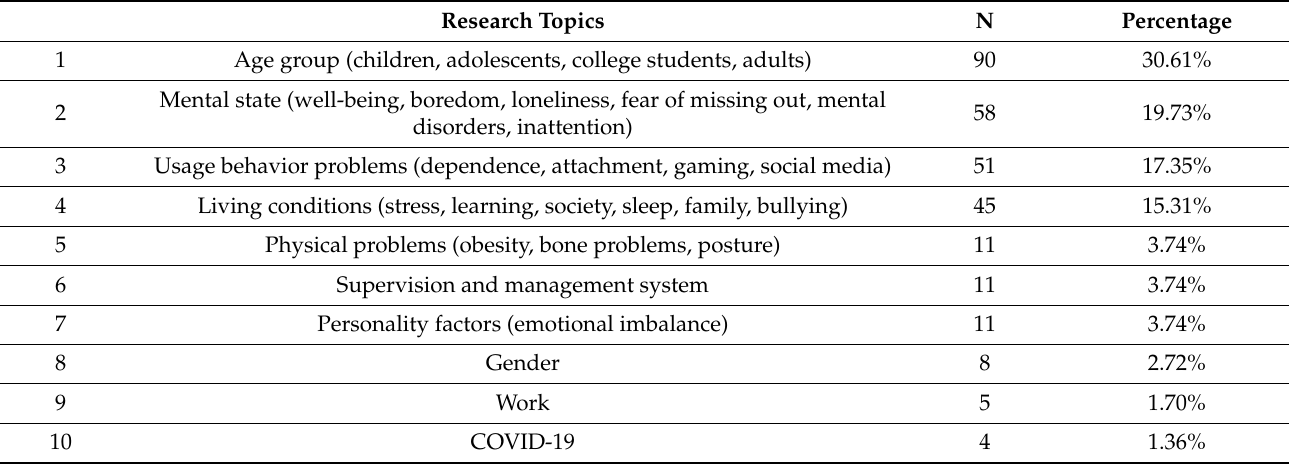
Table 2. Ten research topics for the LDA